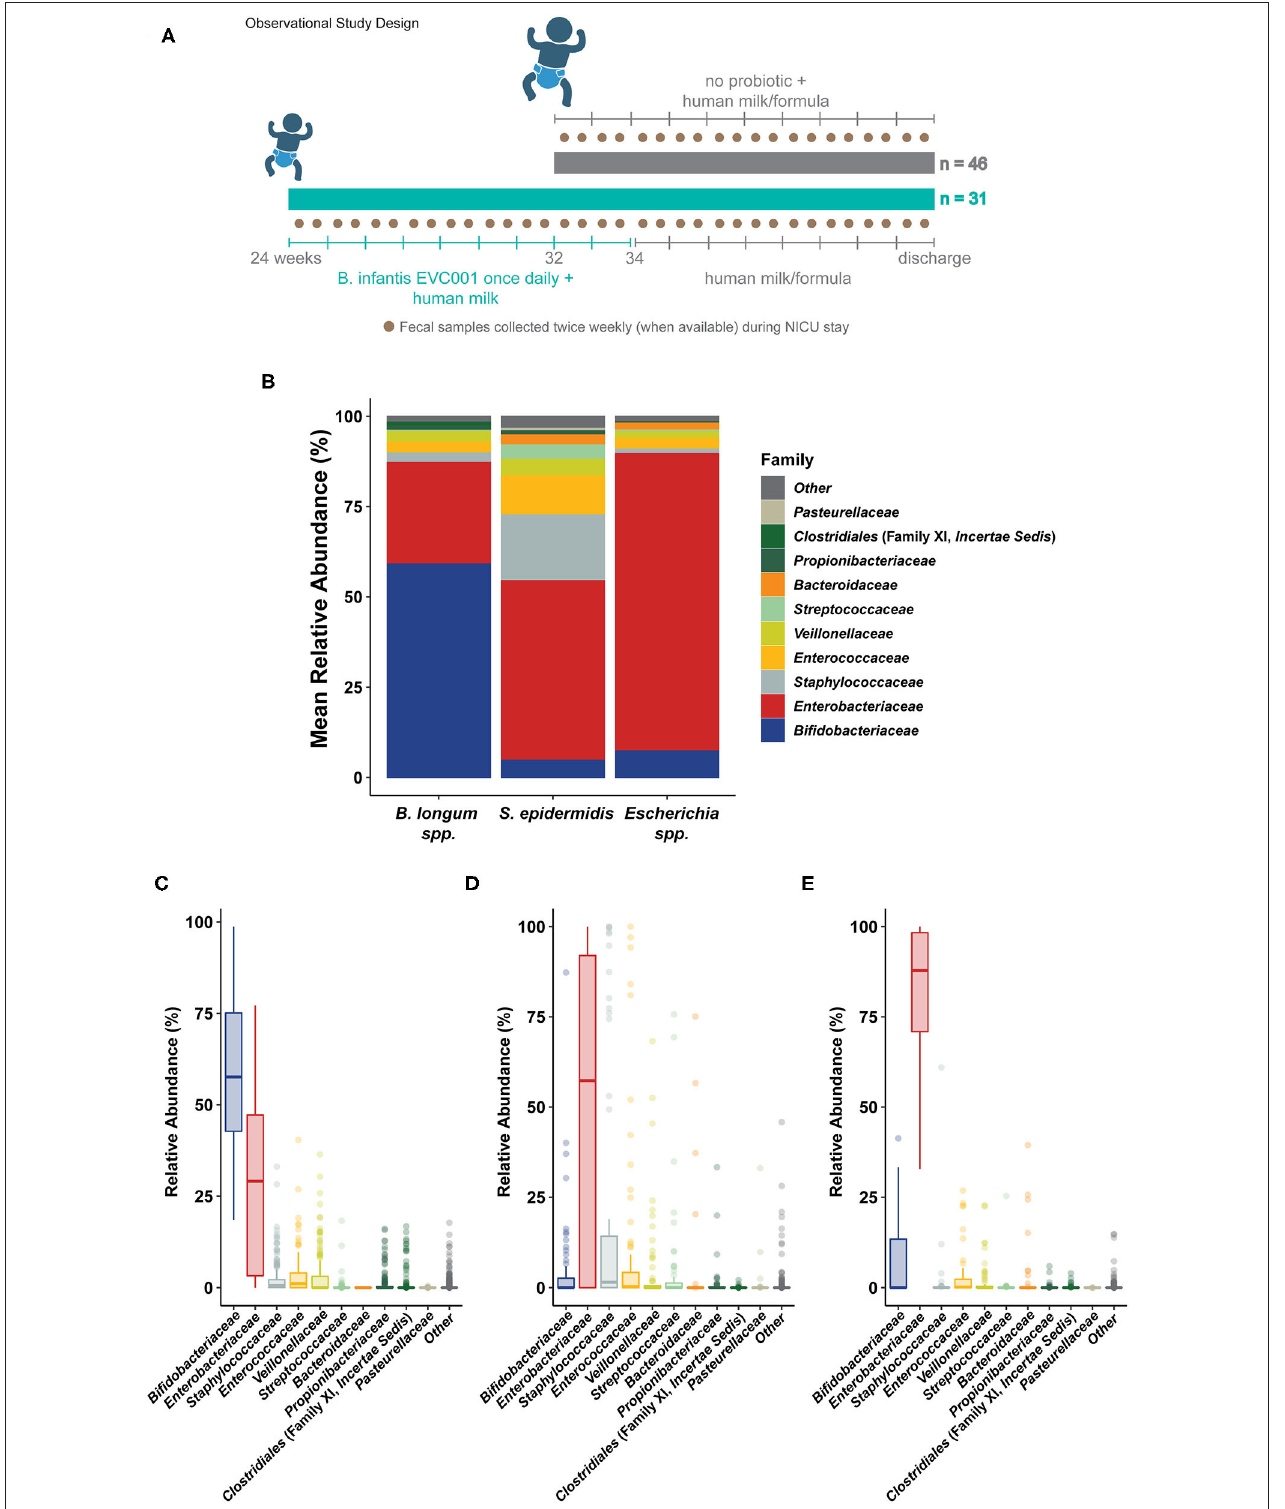
FIGURE 1 | Sample collection and general sample microbiome composition. (A) The general study design is outlined describing the patient cohorts, per hospital feeding protocol, and prospective fecal sampling. Infants born in two hospitals were enrolled shortly after birth and, per hospital protocol, assigned to a feeding protocol based on gestational age at birth and weight at birth. Infants born at > 32 weeks corrected gestational age (cGA) and 1500g were assigned to a feeding